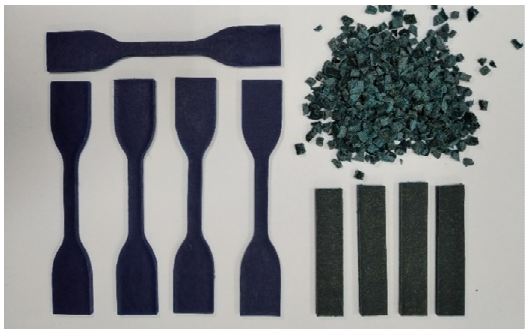
Figure 2 . Composite samples: rHDPE tensile test specimens ( left ), rHDPE/RH 0 impact unnotched test specimens ( right bottom corner ), and rHDPE/RH 1 pellets ( right upper corner ) .